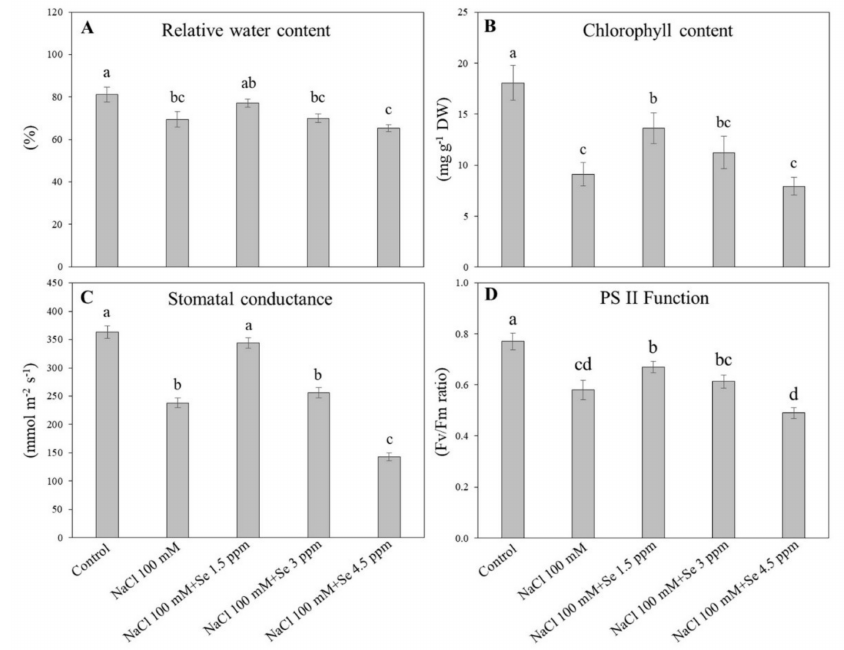
Figure 5. E ff ect of selenium (Se) fertilization on ( A ) relative water content (RWC); ( B ) chlorophyll (Chl); ( C ) stomatal conductance (gs); and ( D ) photochemical e ffi ciency (Fv / Fm) in leaves of black gram plants under salt stress. Values are mean ± standard error ( n = 3). Di ff erent letters in vertical columns show a significant di ff erence. A comparison of mean was confirmed by LSD at p <